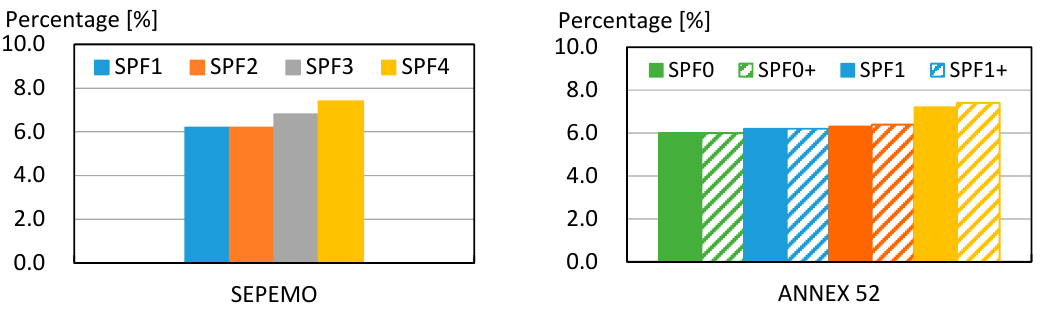
Figure28. UncertaintyinthecalculatedSPFsforSEPEMO( left )andAnnex52( right Figure 28. Uncertainty in the calculated SPFs for SEPEMO ( left ) and Annex 52 ( right ) boundary schemes.